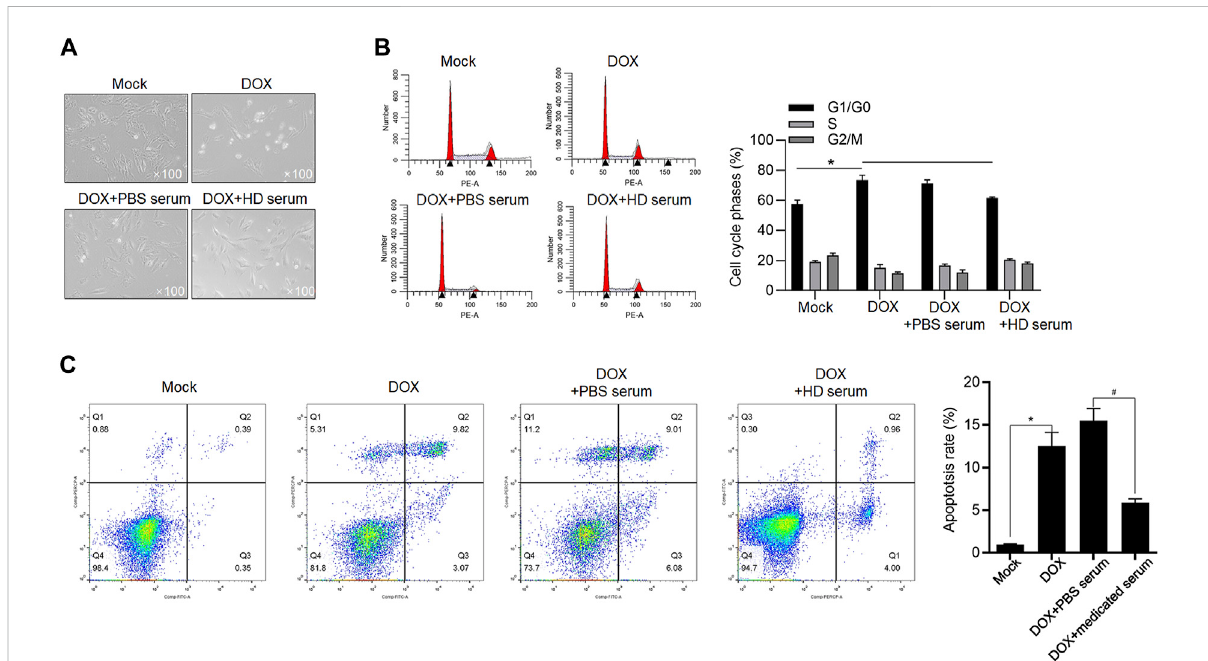
FIGURE 5 YXX keliprotects cardiomyocytesagainst DOX-induced cell injury. (A) . RCMs wereisolated and imaged after 1.5 μ mol/LDOX treatment. (B) .To evaluate the effect of medicated serum on DOX-induced cell cycle arrest, H9c2 cells were exposed to 1 μ mol/L DOX for 24 h, and cell cycle distribution was measured after PI staining. * p < 0.05, mock group; # p < 0.05, DOX + PBS-medicated serum. (C) . After addition of medicated serum for co-incubation with 1.54 μ M of DOX for 24 h, apoptotic cell death of H9c2 was measured by performing Annexin V-FITC/PI double